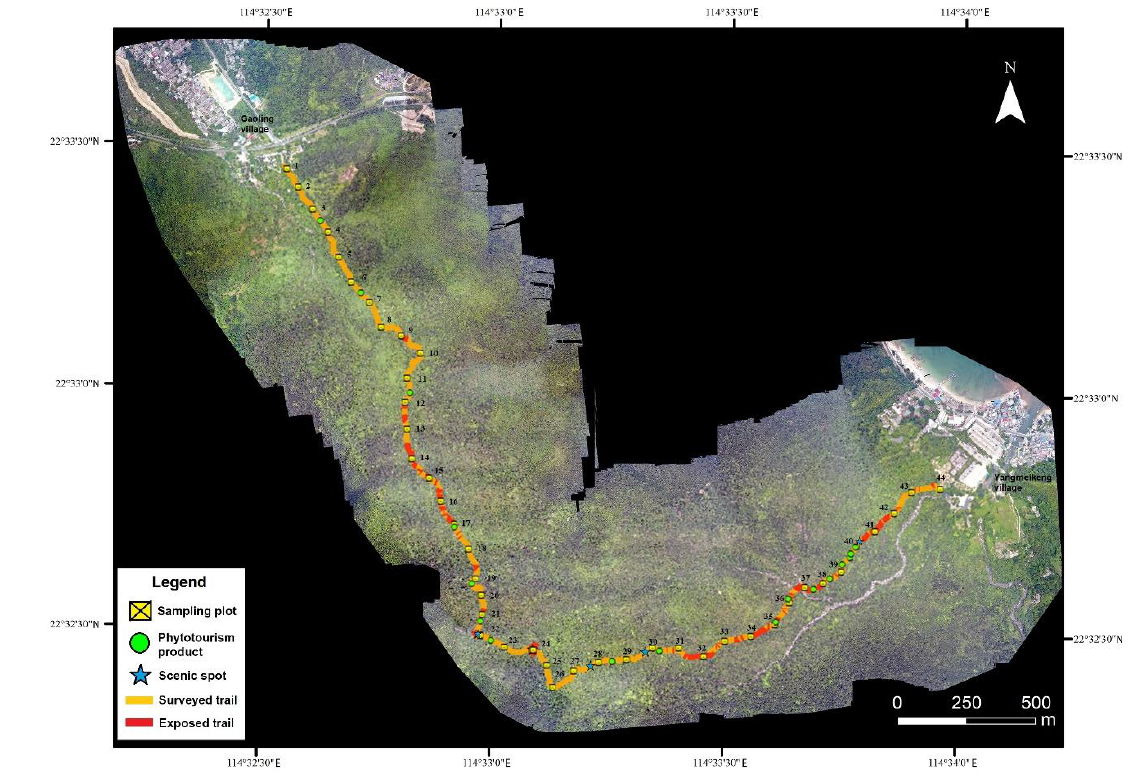
Figure 1. Ortho-mosaic map obtained from the aerial observation conducted along the study site using a Mavic 2 Pro (DJI, China) drone. The trail is highlighted in yellow and the area that is exposed from above along the trail, is indicated with red color. The locations of the sampling points, phytotourism products, and scenic spots were marked along the trail, while the legend corresponded to the symbols used on the map.